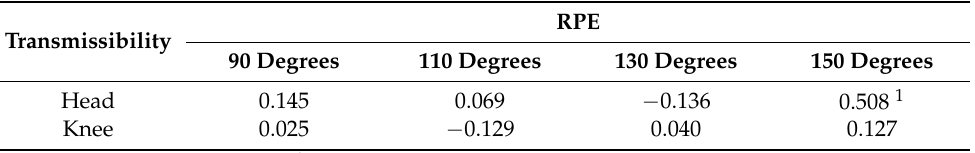
Table 2. Correlation (r) between the rating of perceived exertion (RPE) and the head or knee transmissibility. Correlation analyses were separately performed on data from different